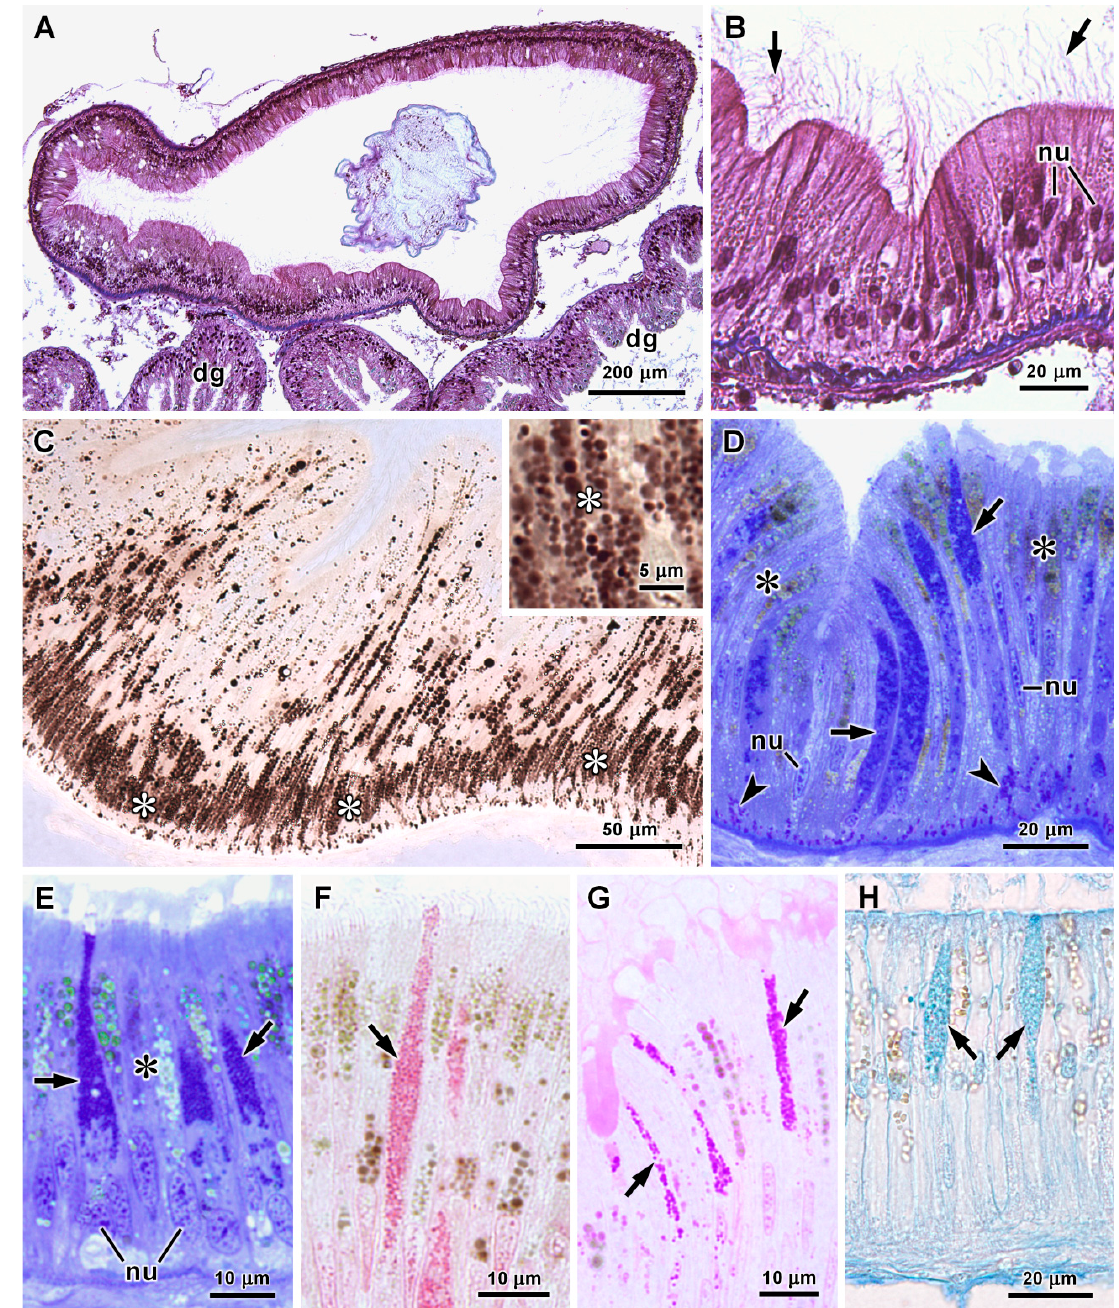
Figure 10. Intestine C. angulata ( A – D , F , G ) and A. fascicularis ( E , H ) in histological ( A , B , H ) and semithin ( C – G ) sections. ( A , B ) Transverse sections of the intestine stained by Masson’s trichrome. The epithelium is covered by cilia (arrows in B ). ( C , inset) Lipid droplets stained by Sudan black in the posterior intestine. Most lipid droplets (asterisks) are concentrated in the basal region of the absorptive cells. ( D ) Basophilic secretory cells (arrows), absorptive cells (asterisks) and basal cells (arrowheads) in the anterior intestine of C. angulata . Methylene blue and azure II staining. ( E ) Basophilic secretory cells (arrows) and absorptive cells (asterisk) in the anterior intestine of A. fascicularis . Methylene blue and azure II staining. ( F , G ) Secretory cells (arrows) stained by tetrazonium reaction (F) and PAS reaction ( G ) in the anterior intestine of C . angulata . ( H ) Secretory cells (arrows) stained by Alcian blue in the anterior intestine of A. fascicularis . dg—digestive gland, nu— nuclei.